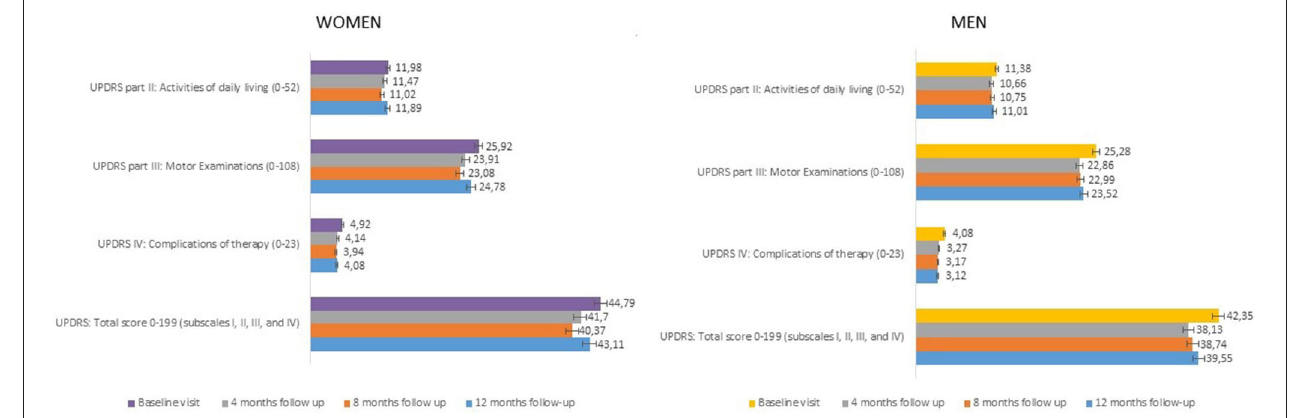
FIGURE 2 | UPDRS scores (part II, III, IV, total scores) at each study visit ( ± SE). UPDRS, Unified Parkinson’s Disease Rating Scale; SE, Standard Error.